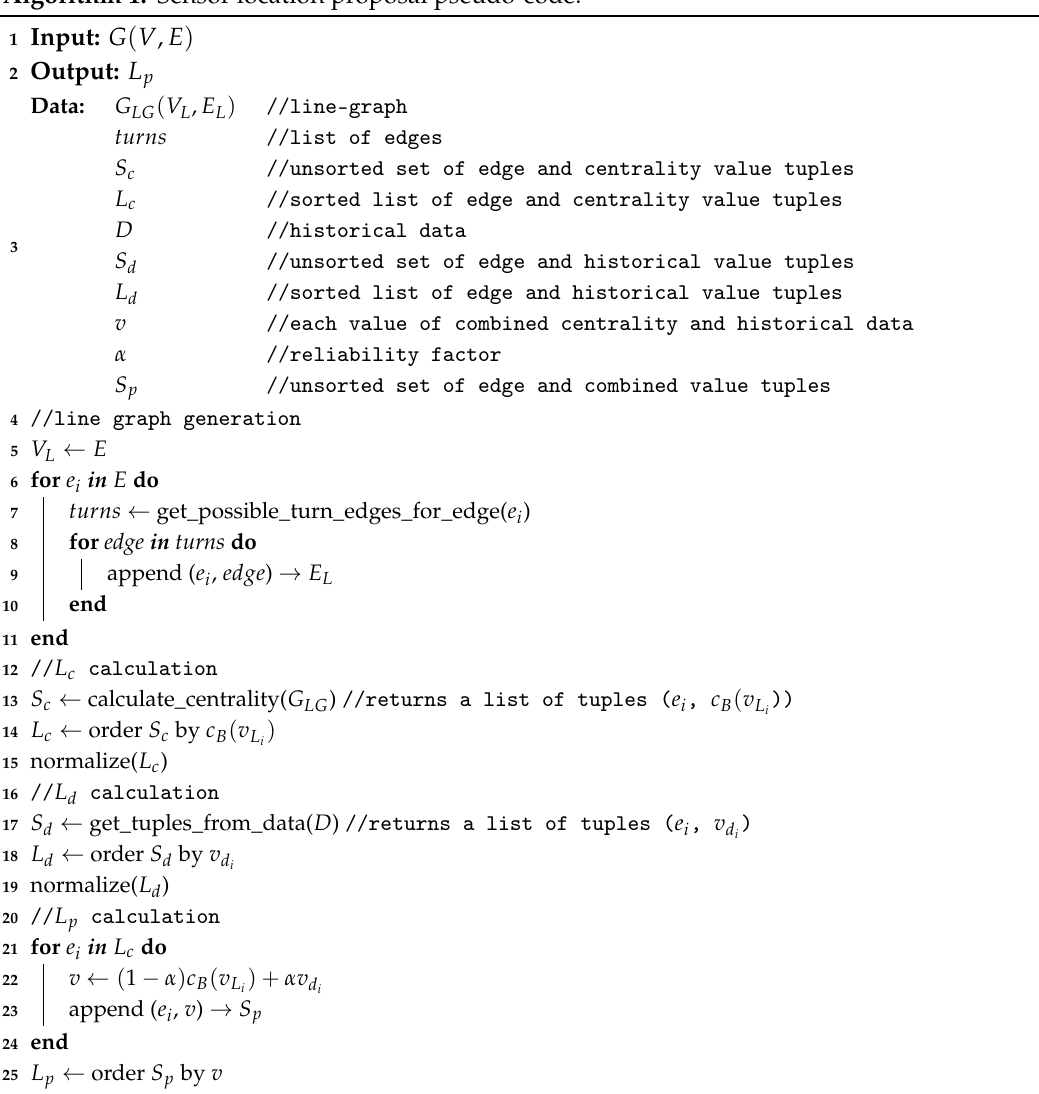
Algorithm 1: Sensor location proposal